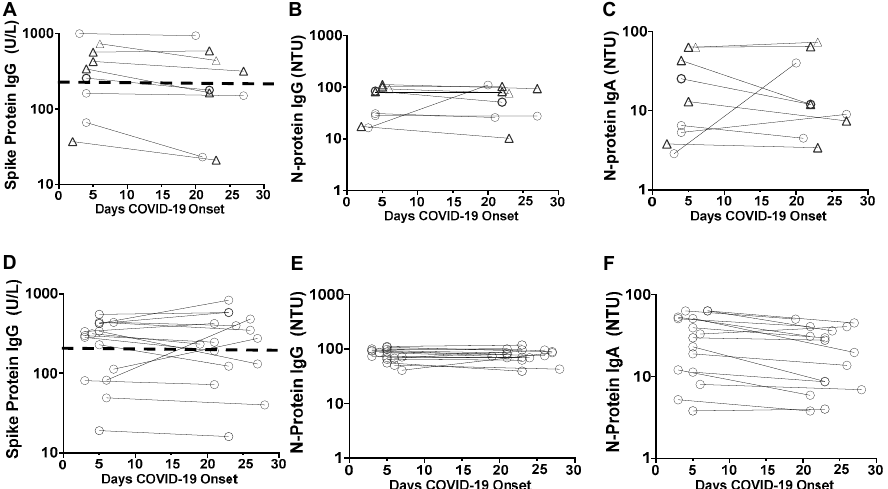
Figure 2. Prospective monitoring of antibody levels in the vaccinated ( A – C ) and non-vaccinated COVID-19 patients ( D – F ). The horizontal dotted line of 250 NTU represents the antibody activity saturation level at 1:100 serum dilution.